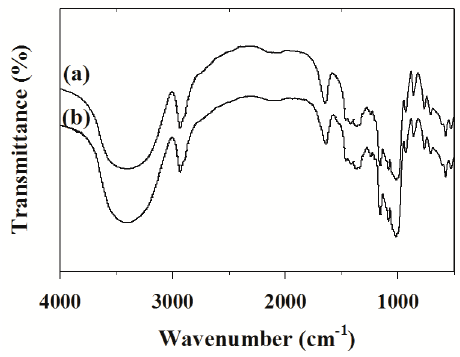
Figure 7. Fourier transform infrared (FT–IR) spectra of MPS before (a) and after (b) adsorption of TPS.